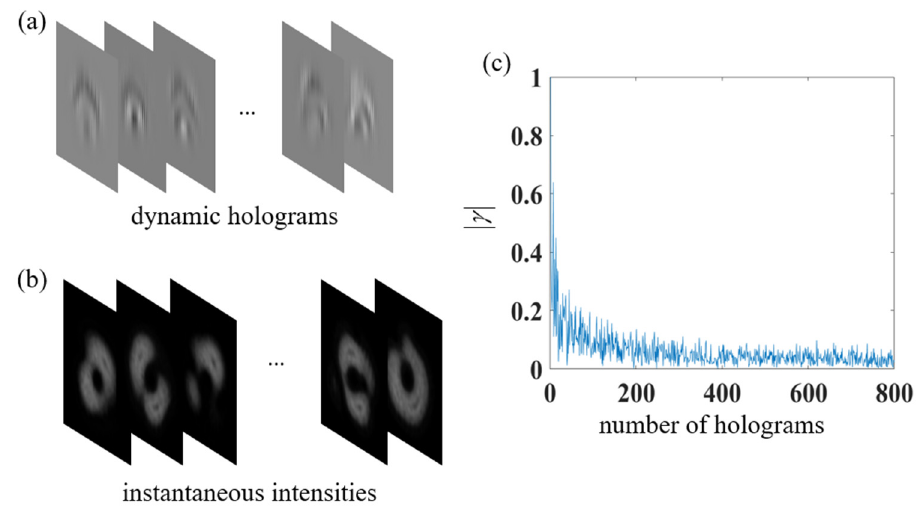
Figure 7. ( a ) A schematic illustration of the dynamic computer-generated hologram. ( b ) The experi- mental results of the instantaneous intensities for the dynamic hologram. ( c ) The absolute value of the degree of coherence | γ | between different modes versus the number T of the hologram frames.